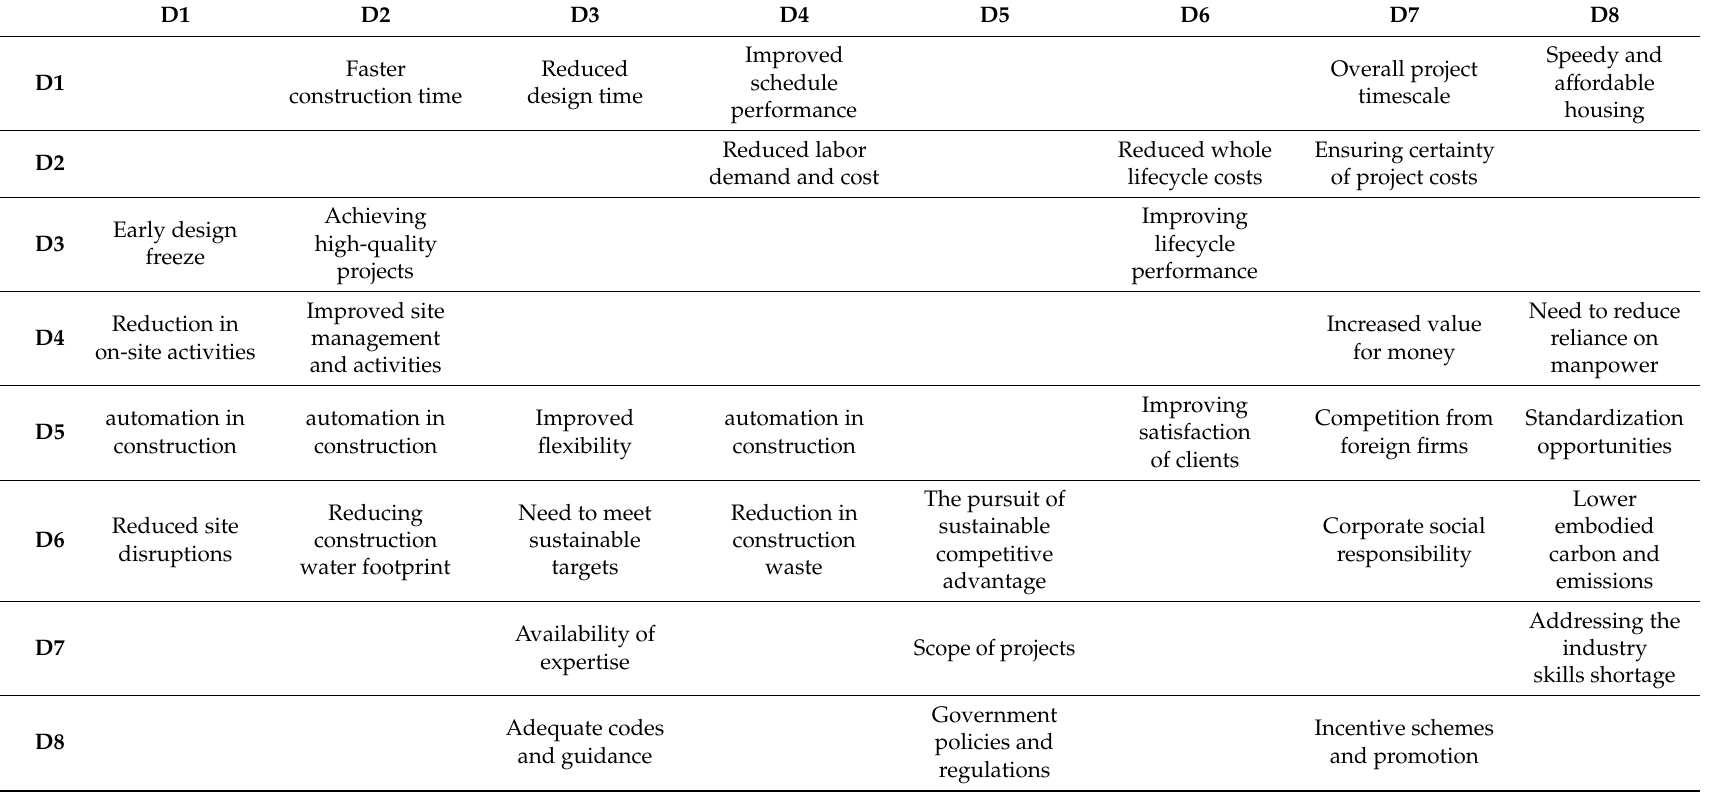
Table 8. Transitive links of the drivers of OSC based on the Interpretive Logic-Knowledge